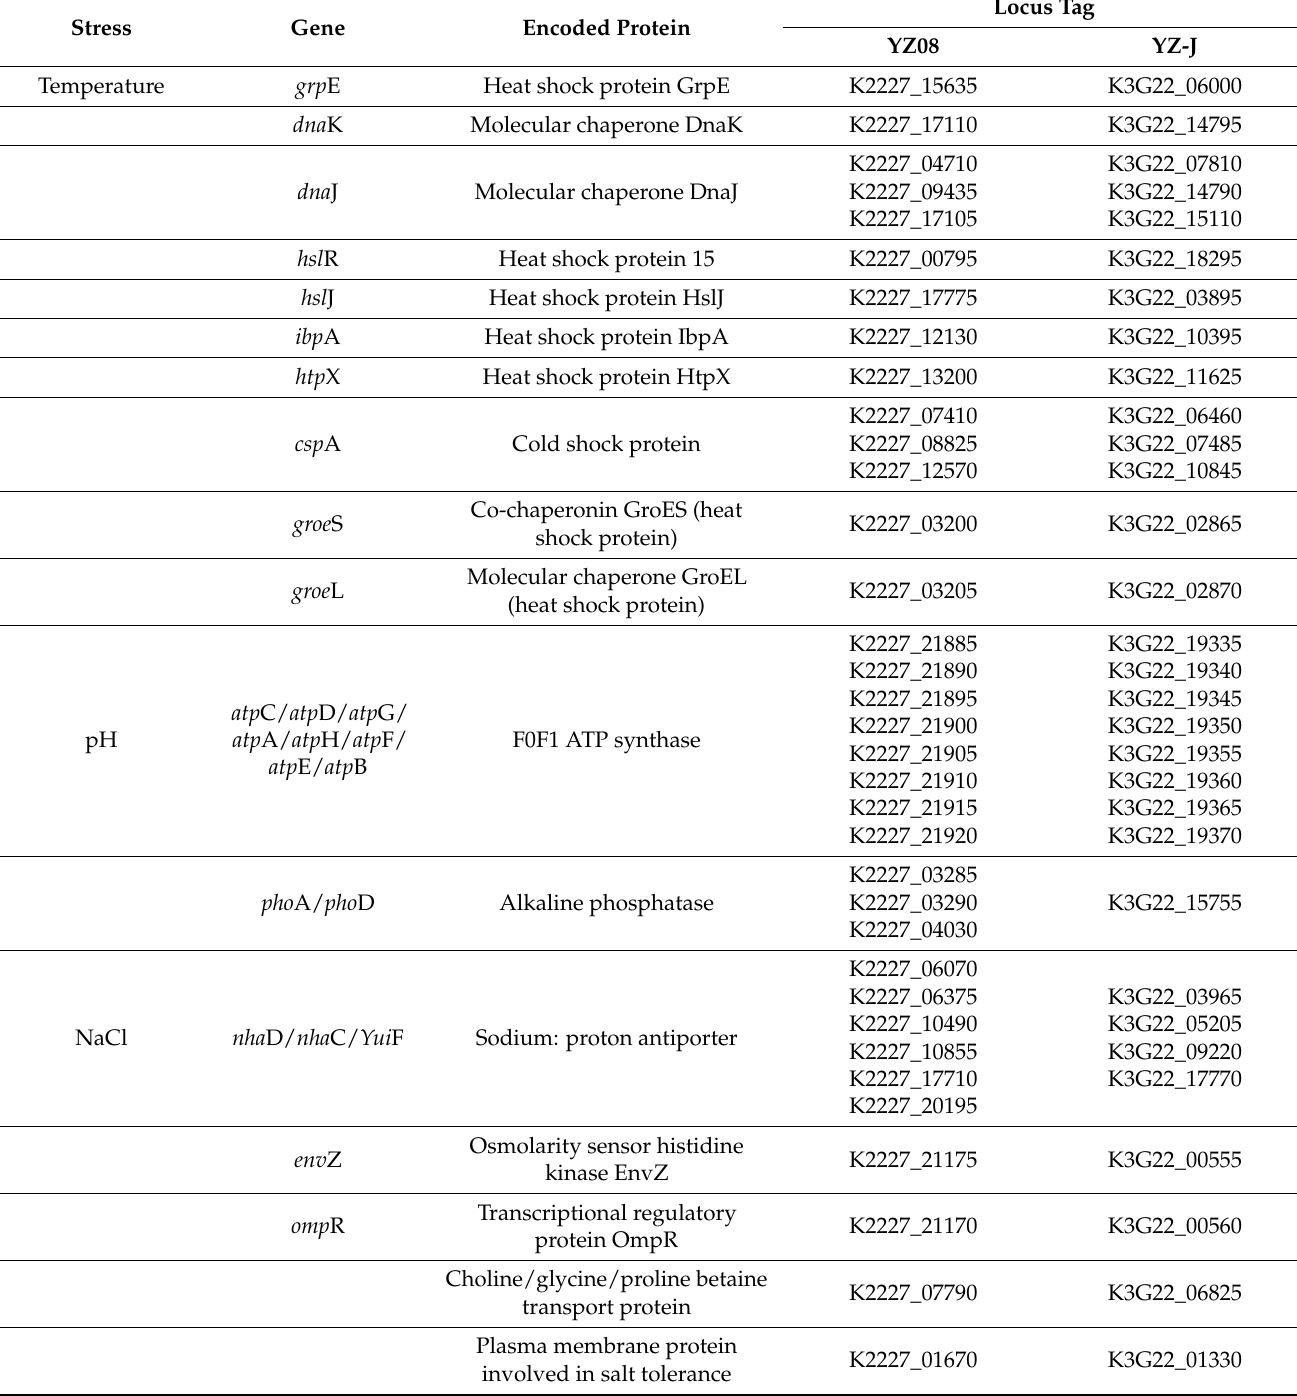
Table 1. Stress-related genes of S. putrefaciens YZ08 and